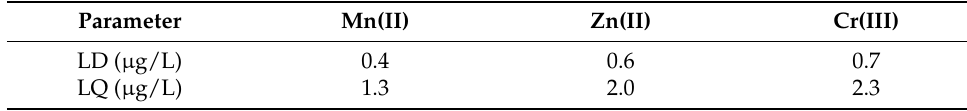
Table 2. Validation parameters of the AAS